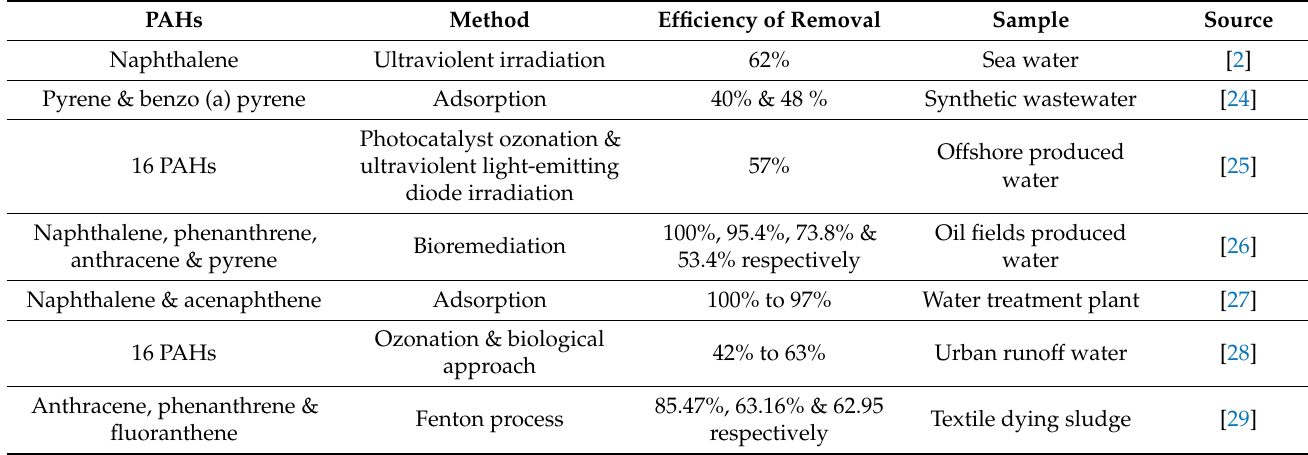
Figure 2. Various methods of removal of PAHs from produced water. Table 3. Various methods for removal of polycyclic aromatic hydrocarbons.